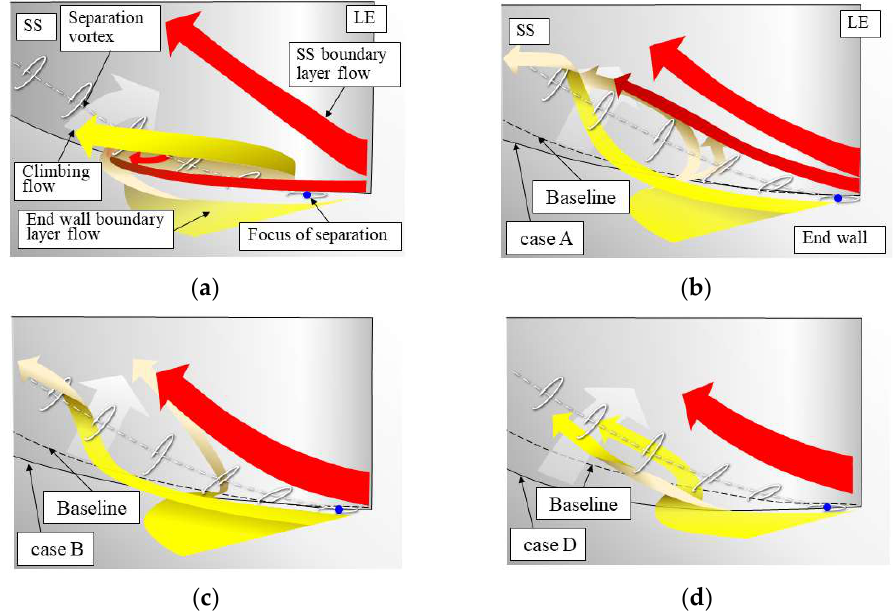
Figure 18. Sketched three-dimensional flow at the near-stall point. ( a ) Baseline; ( b ) case A; ( c ) case B;